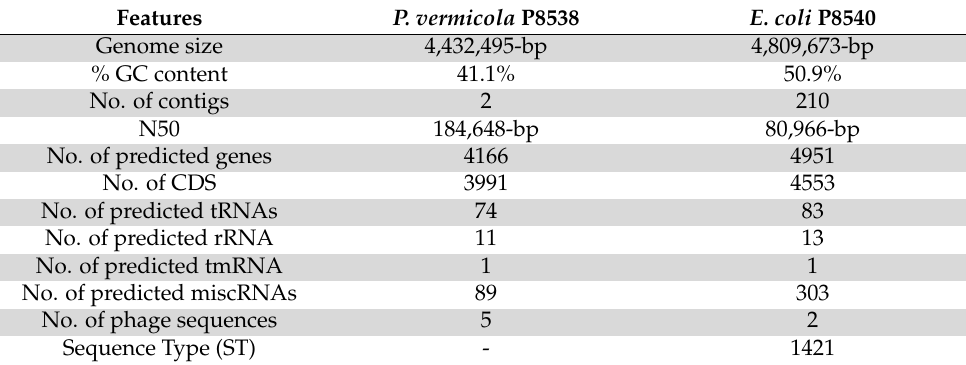
Table 2. Genome features of P. vermicola P8538 and E. coli P8540 isolates harboring bla NDM-1